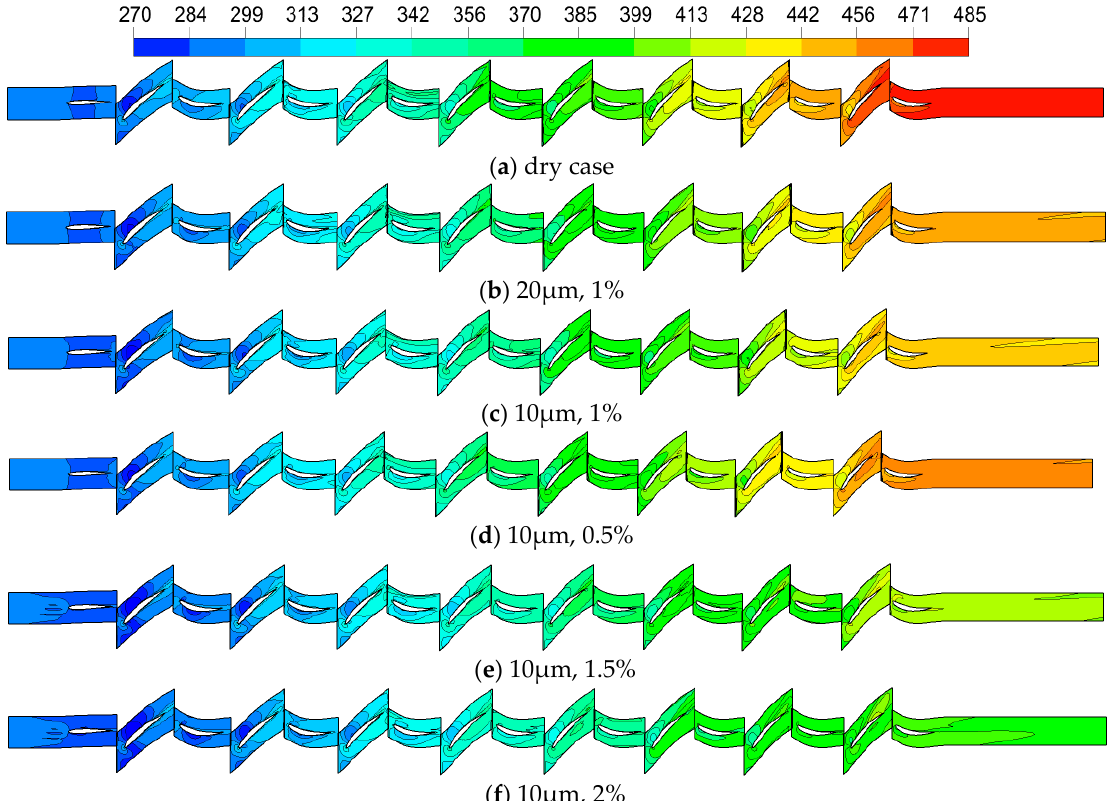
Figure 20. Temperature contours of 50% span on the blade to blade surface under different water injecting cases.